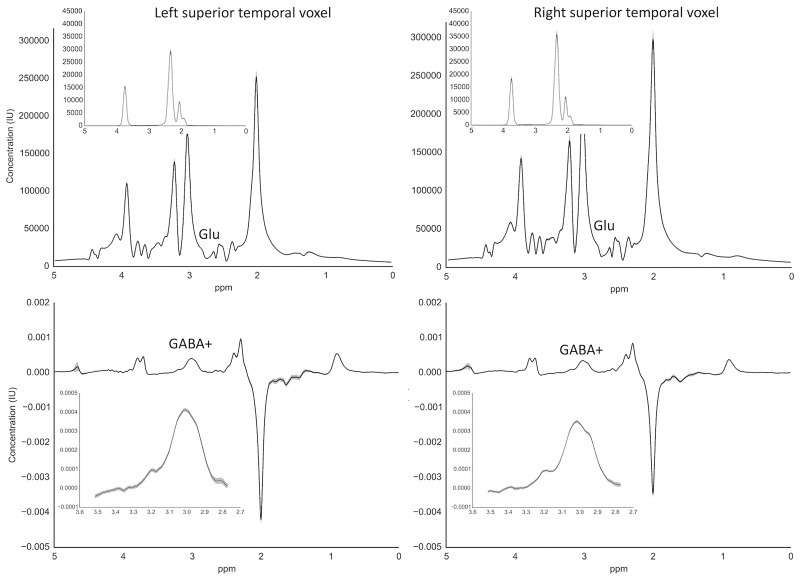
Average 80ms TE PRESS (for glutamate) and MEGA-PRESS spectra (for GABA+).Top: average left and right voxel 80ms TE PRESS spectra with isolated glutamate spectrum (inset) from TARQUIN. Bottom: average left and right voxel MEGA-PRESS edited spectra with isolated GABA+ peak at 3.0ppm (inset). The shading represents standard error from the mean.